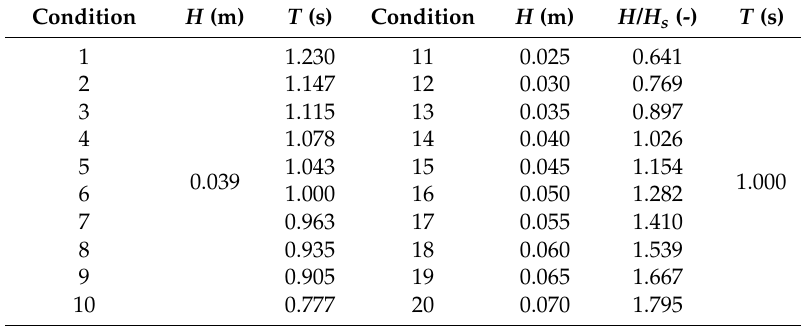
Table 6. Experimental test matrix for regular waves.